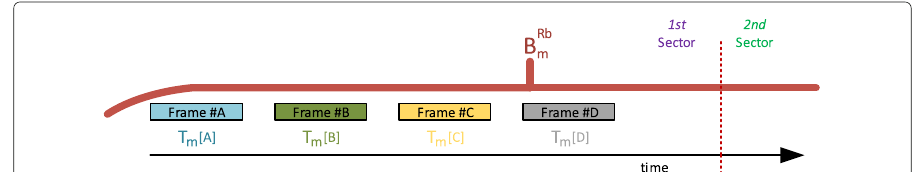
Fig. 8 Robust design for the outer